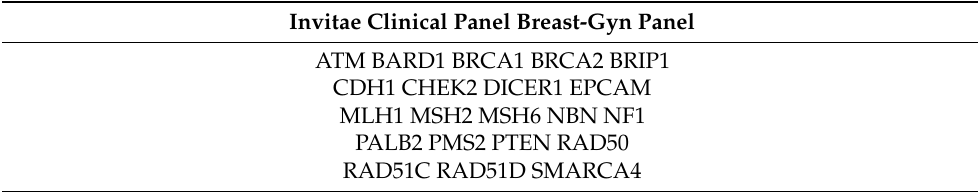
Table A1. Hereditary cancer genes tested by commercial lab